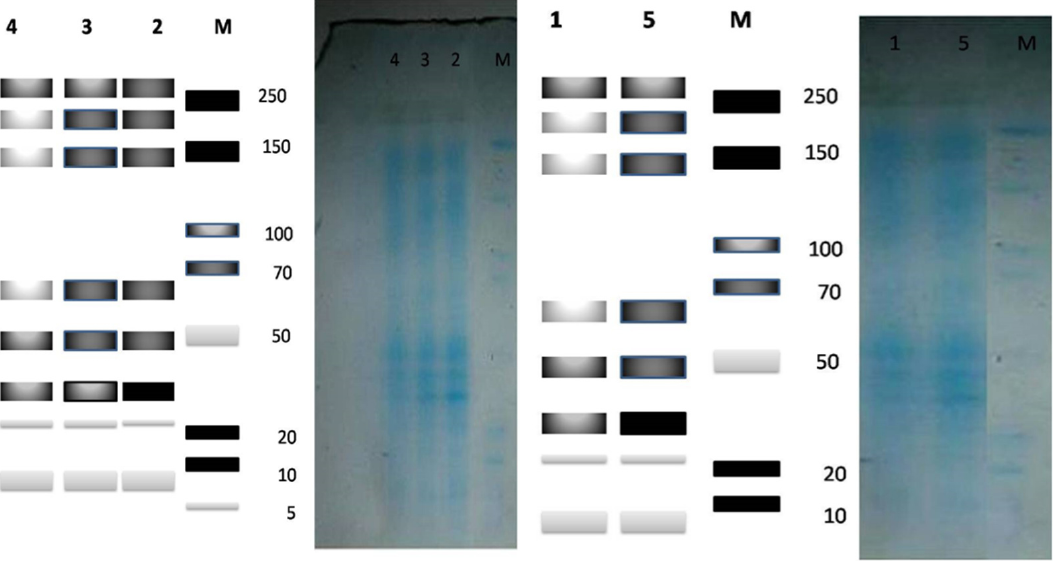
Figure 12. Photographs and zymograms of the protein patterns of Zea mays. M: Marker, 1: Control, 2: U. fasciata 5 mg/mL, 3: U. fasciata 10 mg/mL, 4: U. lactuca 5 mg/mL, 5: U. lactuca 10 mg/mL.